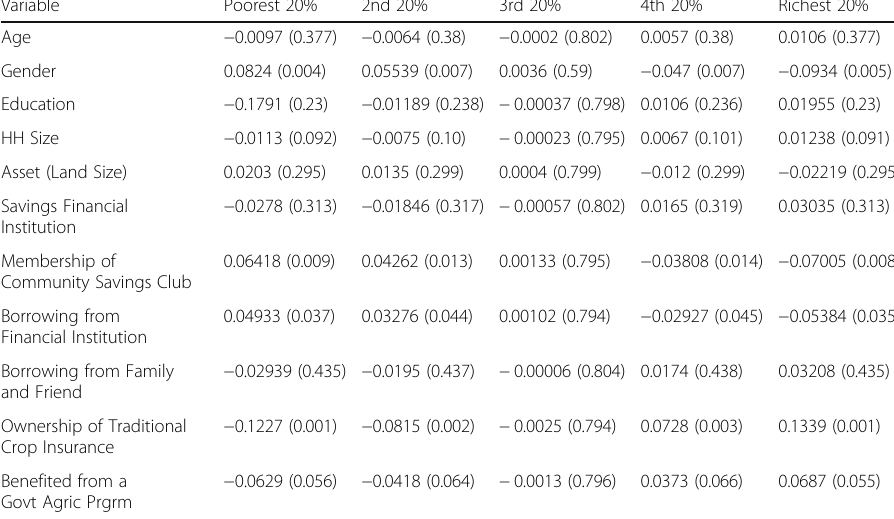
Table 2 Marginal Effects (Ordered Logit